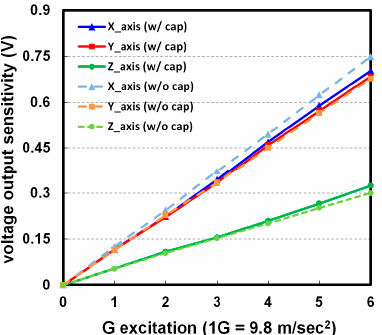
Figure 6. Voltage output sensitivities of three-axis CMOS MEMS accelerometer with/without capping.